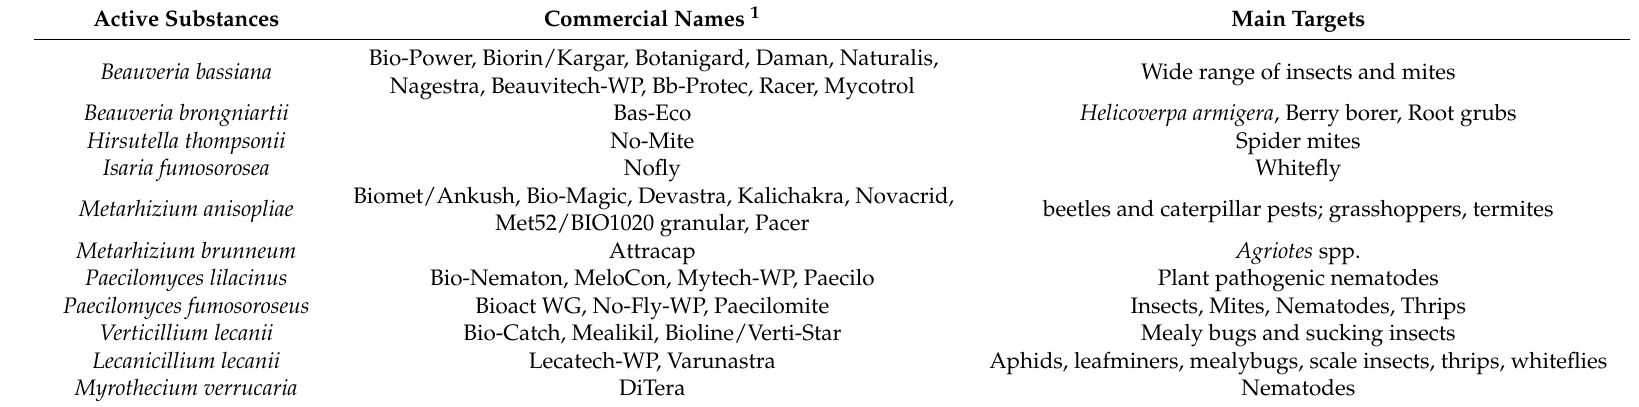
Table 2. Selection of commercial products based on entomopathogenic